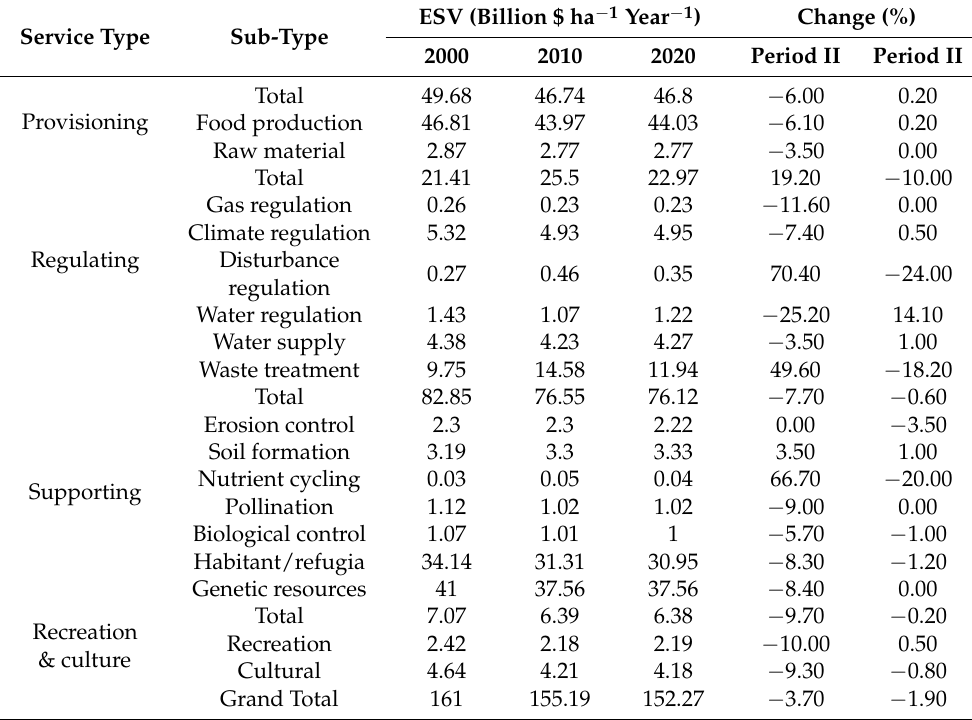
Table 8. Estimated values for various ecosystem functions in